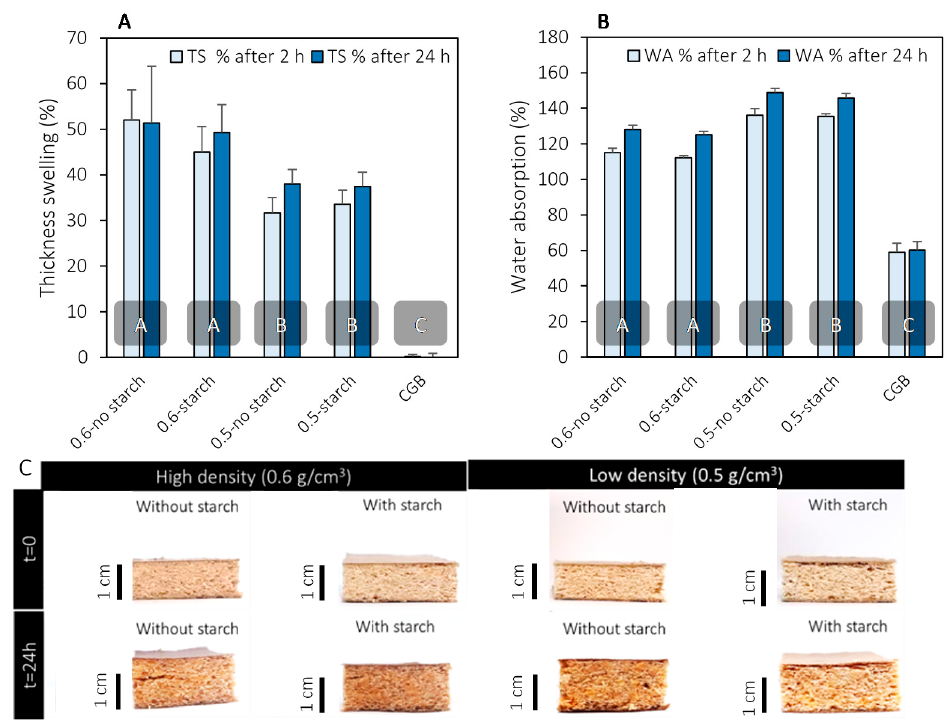
Figure 9. ( A ) thickness swelling of low and high-density panels and comparison with commercial gypsum board (CGB), ( B ) water absorption of low and high-density panels and comparison with this same CGB, and ( C ) sample images at time zero and at the end of the test (after 24 h). In Figures A and B, columns with common letters are not statistically different at the 95% confidence level.